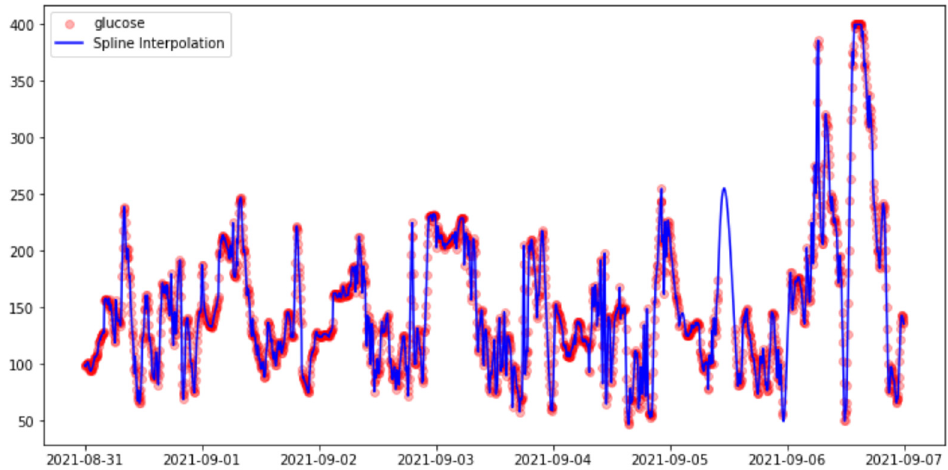
Figure 7. Comparing the true CGM time series with the imputed CGM using spline interpolation, in one-week period for patient 588.